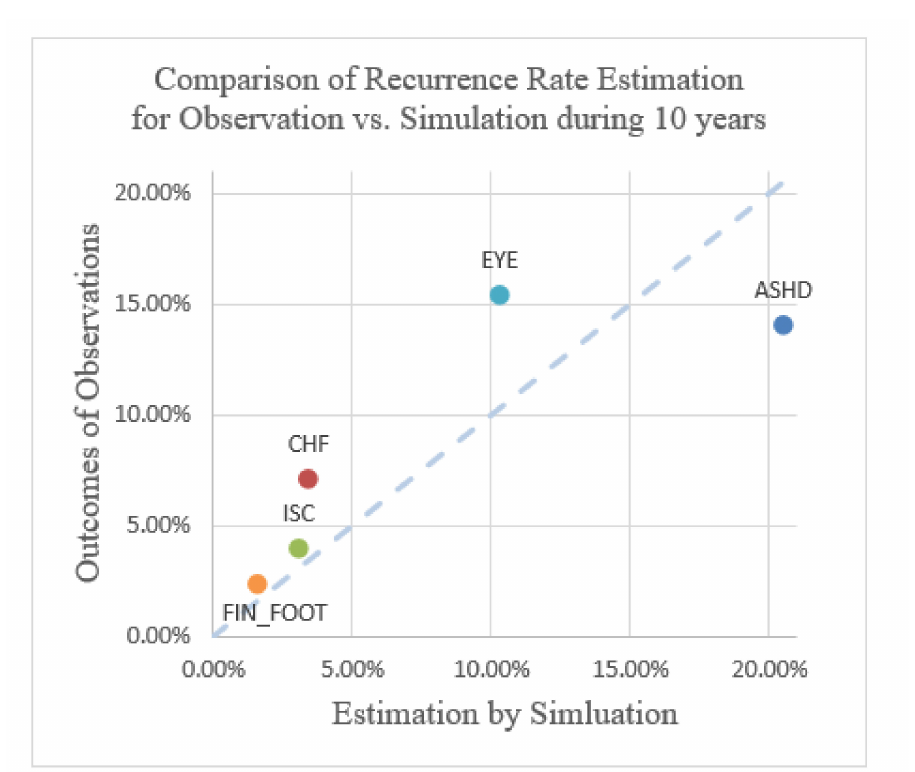
Figure 7. Comparison of recurrence rate estimation for observation vs. simulation over the course of 10 years.